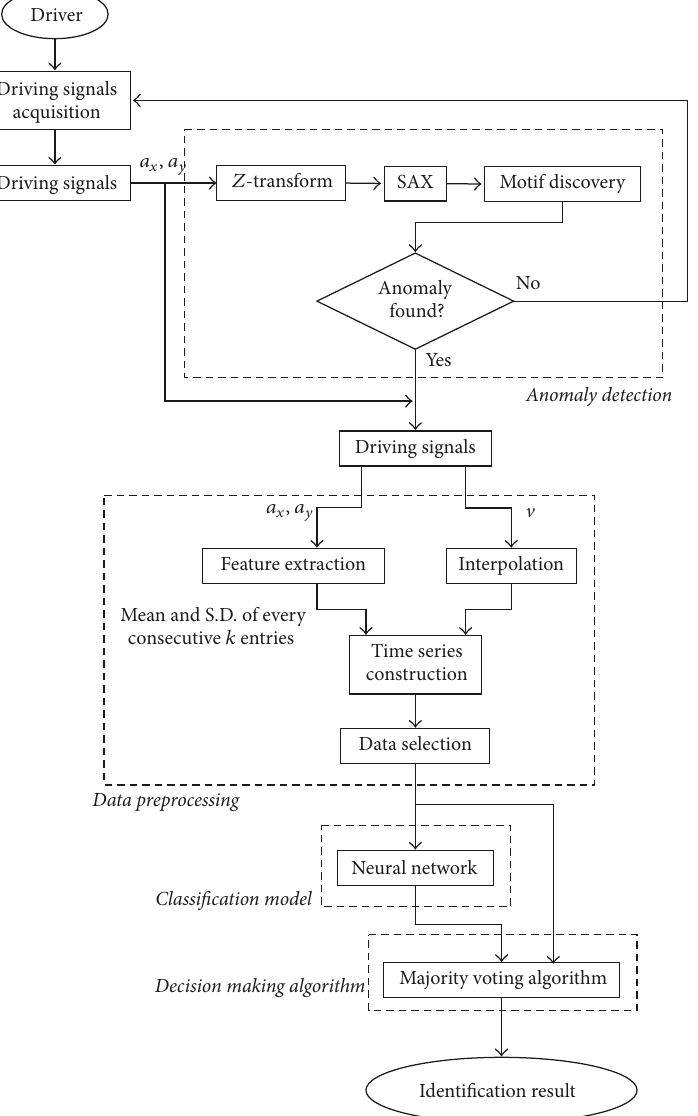
Figure 1: Proposed algorithm for constructing classification model and driver